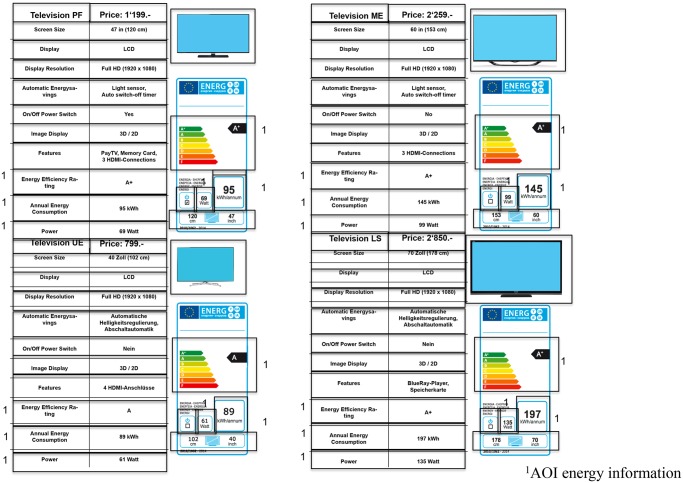
Areas of interest (AOI) defined for the television task in the label condition.Each box represents an AOI used for data analysis. The AOIs marked with number 1 were combined with the AOI energy information.